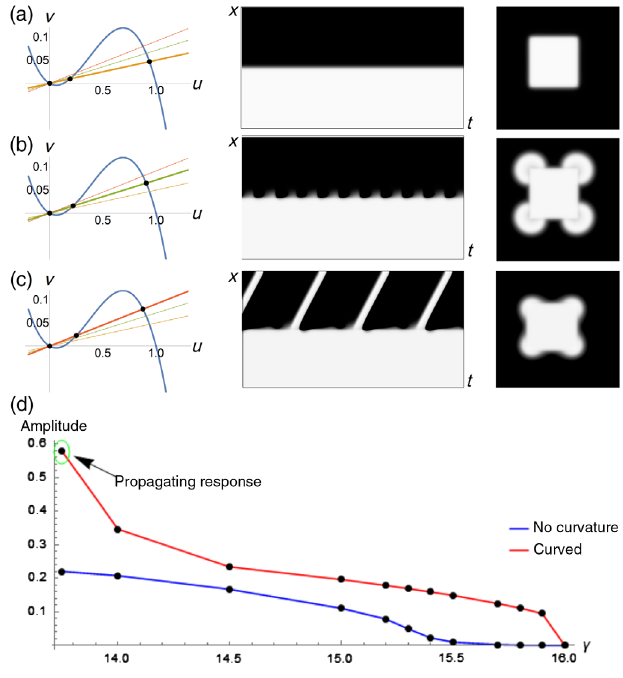
FIG. 4. Influence of the nullcline slope 1 = γ of the bistable zone on ectopic wave generation. (a) – (c) Induction of ectopic activity for γ ¼ 20 (a), 14 (b), or 11 (c). Left panels: Nullclines. Middle panels: Space-time plots of 1D simulation. Right panels: Snap- shot from 2D simulation. (a) For γ ¼ 20 , only the stationary solution is found in 1D and 2D. (b) For γ ¼ 14 , subthreshold oscillatory activity is seen in 1D and periodic waves emanating from the corners in 2D. (c) For γ ¼ 11 , a propagating response is observed both in 1D and 2D. Like in (b), the ectopic origins are located in the corners of the bistable regions. (d) Bifurcation diagram for a curved ( R ¼ 36 . 0 , red line) and flat (blue line) interface between the monostable (i.e., excitable) and bistable (i.e., quasistable depolarized)